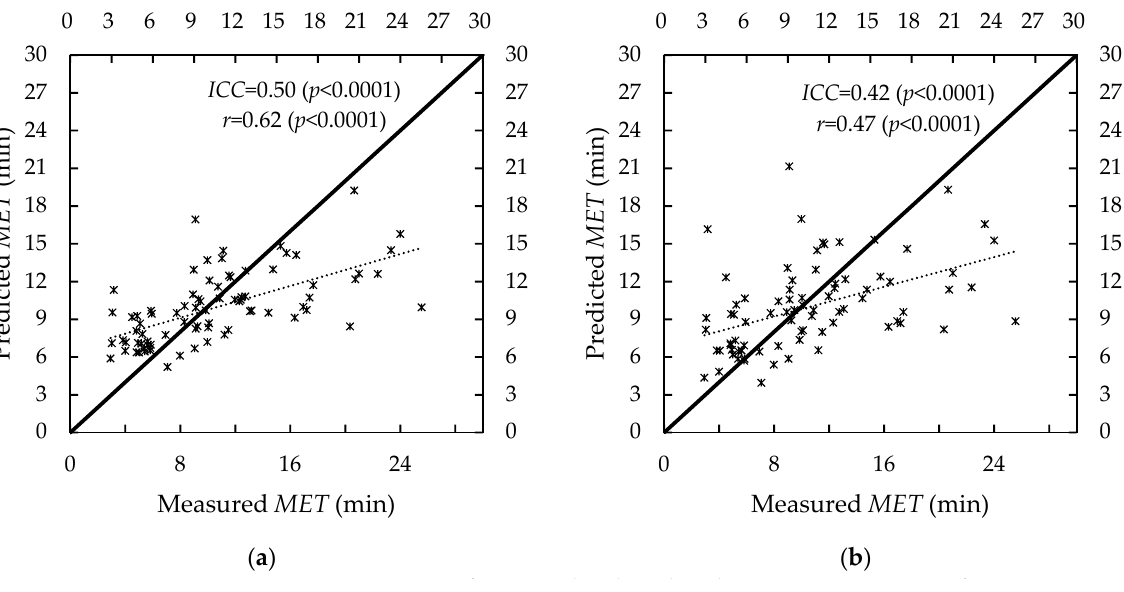
Figure 5. Comparison of measured and predicted MET . ( a ) Equation (7), ( b ) Equation (9).